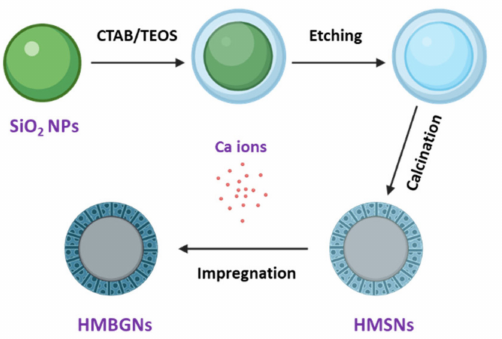
Figure 1. Schematic illustration of the synthesis process of